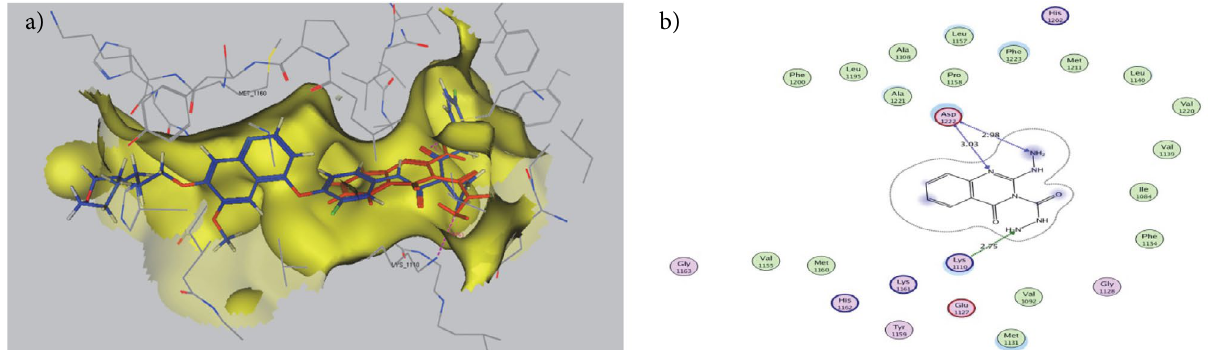
Figure 3. (a) The superposition of foretinib (blue) and compound 13 (red) docked in the binding site of c-Met, the dotted lines represent H-bonding interactions; (b) 2D ligand interaction of 13 in binding site of c-Met.